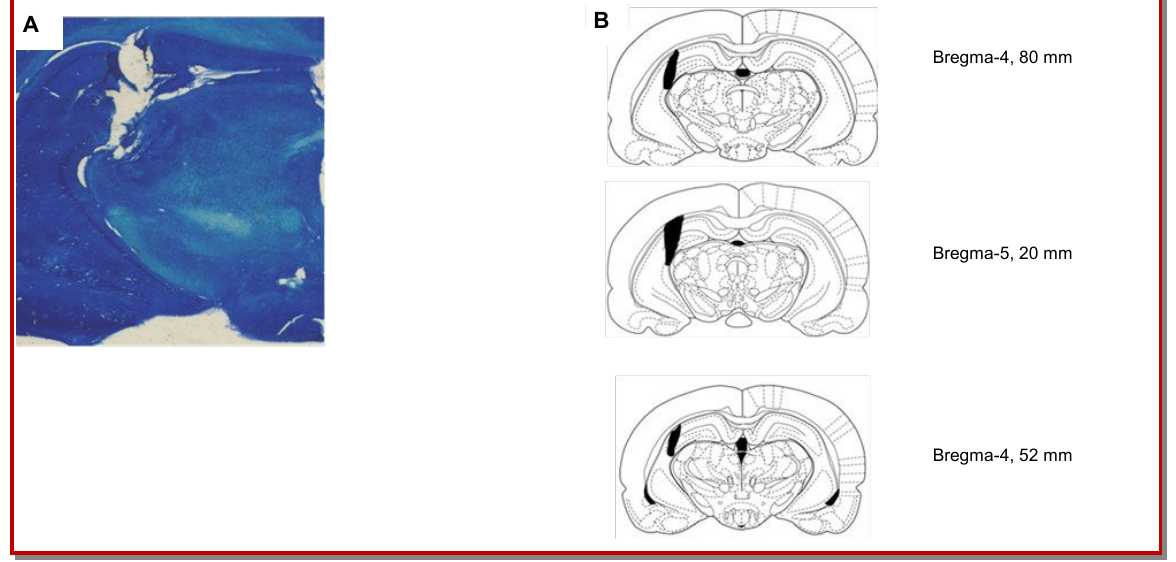
Figure 4: (A) Photomicrographs of coronal Nissl-stained sections from a representative hippocampus lesioned rat. (B). Serial histo- logical reconstructions of representative extent (Black) of electrolytic lesions in hippocampus in the rat according to Paxinos and Watson, 1998. Numbers indicate distance posterior from bregma according to Paxinos and Watson, 1998.